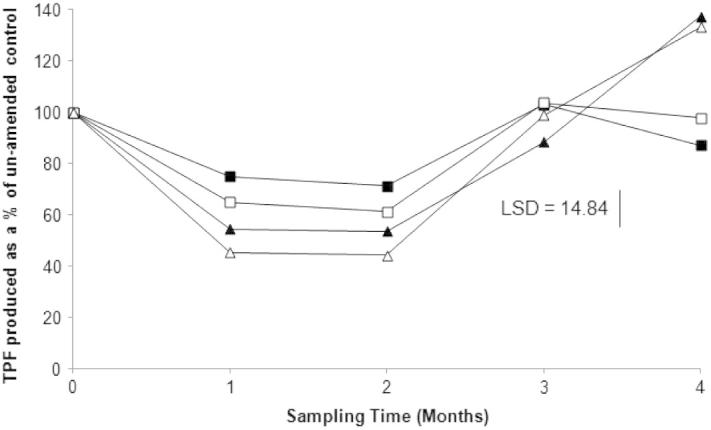
Percentage dehydrogenase activity in azoxystrobin-amended soils compared to 0 mg kg−1 controls. TPF = triphenyl formazan. ■ 1 mg kg−1 □ 5 mg kg−1 ▴ 10 mg kg−1 Δ 25 mg kg−1. Each data point represents the mean of 4 experimental replicates.